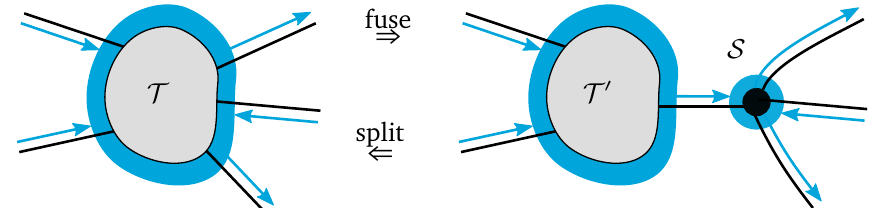
Figure 21: Fusion and splitting of a symmetric tensor. From the fuse-operation acting on a tensor T (left-to-right) we obtain the fused tensor T (cid:48) together with a split-node S = F † which encodes the symmetry fusion rule for the irreps (cyan filled circle) on the fused links and the index enumeration in the degeneracy space (black filled circle on top). The inversion of the process, splitting the fused link into the three original links (right-to-left), is equivalent to a contraction of the split-node over the fused link. ¯ ∂ ¯ ∂ ≥ (cid:81) m due to collisions. The subtensor’s exact position in the degeneracy subspace (cid:96) (cid:96) r = k r + 1,..., ∆ α + 1 D (cid:96) is determined by the interval of degeneracy offsets ∆ α , where α is the (cid:96) (cid:96) enumeration index of collision (cid:96) ,..., (cid:96) into (cid:96) as specified with the fuse-node F k m